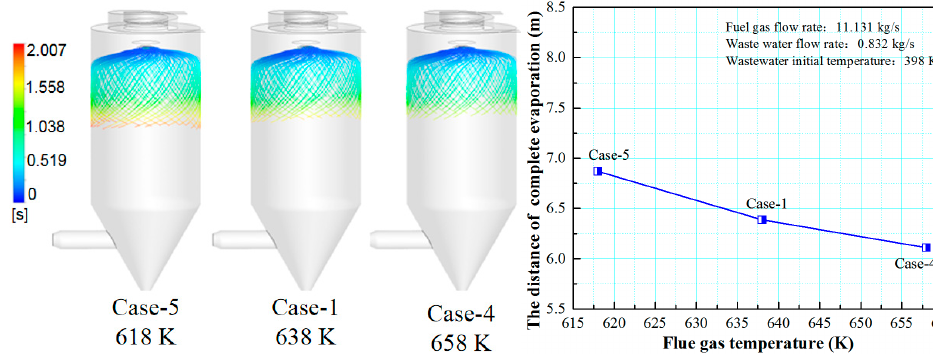
Figure 9. Effect of flue gas temperature on evaporation performance.